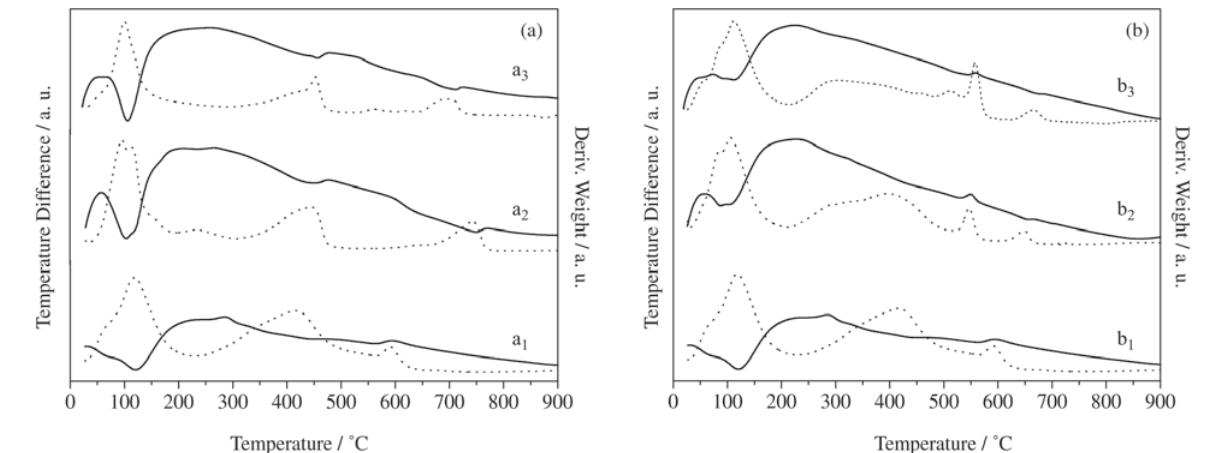
Figure 6. DTGA-DTA curves of the precursors. a) LaNi x = 0.4, (b